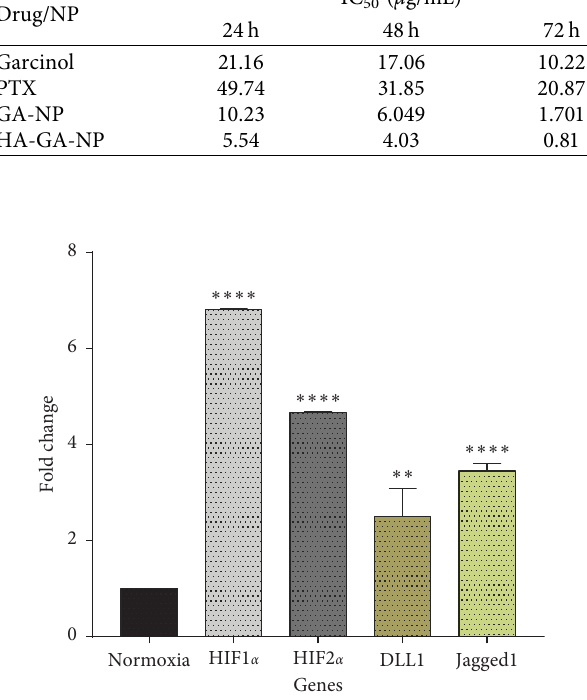
Figure 3: Comparison of the expression of genes (HIF1 α , HIF2 α , DLL1, and Jagged1) under normoxic and hypoxic conditions ( ∗∗∗∗ p < 0 . 0001; ∗∗ p < 0 .